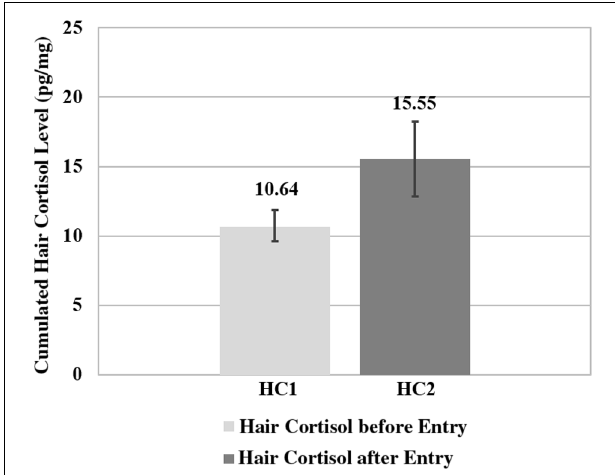
FIGURE 1 | Mean cumulated hair cortisol levels during the 3 months before (H1) and 3 months after kindergarten entry (H2) of N = 24 children.